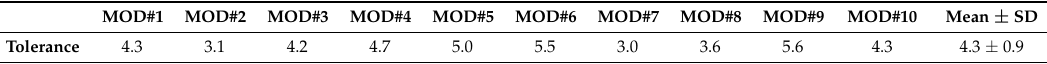
Table A4. Guide hole tolerance ( ◦ ) of the computer-assisted implant surgical guides. MOD, model. SD, standard